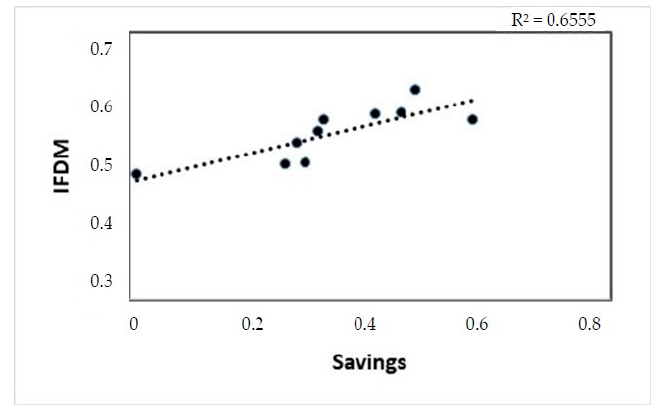
Figure 6. Scatterplot Savings x IFDM - Temporal Dimension.